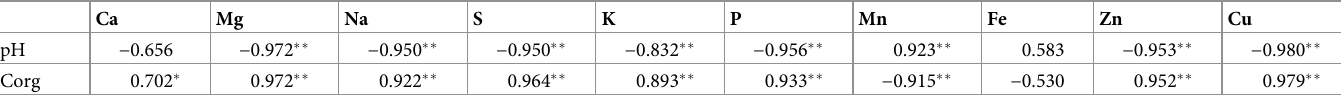
Table 4. The value of the correlation coefficients between the individual substrate parameters after the end of the experiment. Ca Mg Na S K P Mn Fe